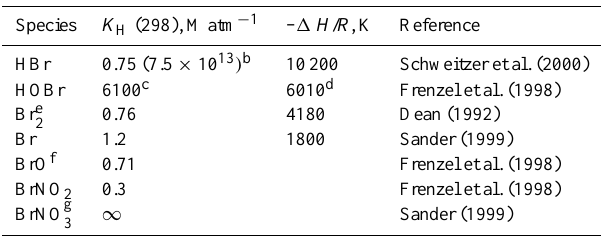
Table 2e. Tropospheric bromine chemistry in GEOS-Chem: Henry’s law constants a .